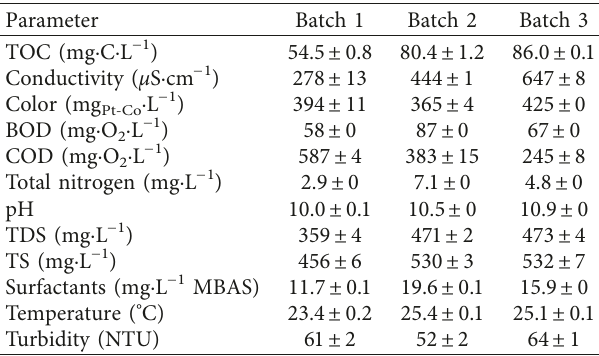
Table 3: Mean values ( standard deviation) of the parameters analyzed when characterizing the laundry wastewater. ± Parameter